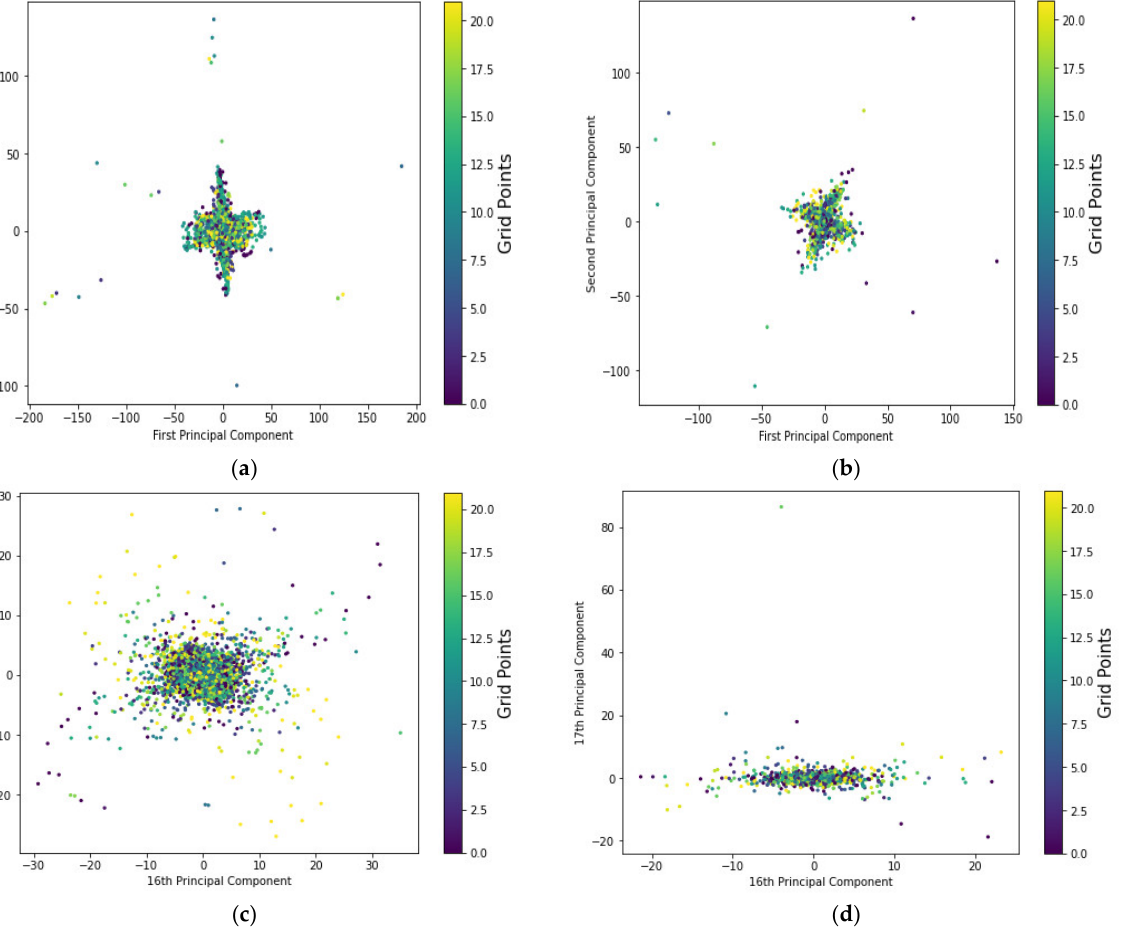
Figure 7. Distribution of principal components of datasets collected during month 2 with their corresponding RPs. ( a ) Training dataset Day1M2, ( b ) Testing dataset Day1M2, ( c ) Training dataset Day1M2, ( d ) Testing dataset